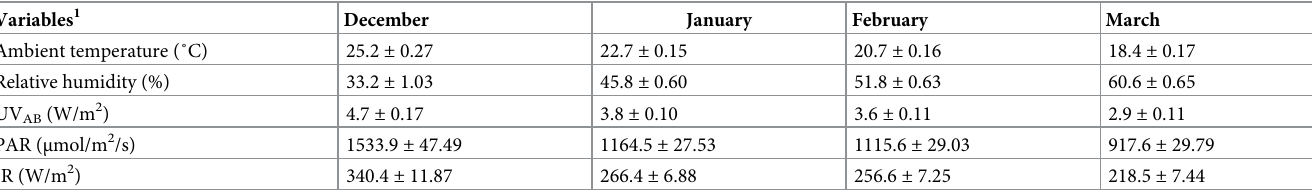
Table 1. Mean daily ( ± SEM) outdoor conditions during ranging time across the months in TAS (n = 101 days). Variables 1